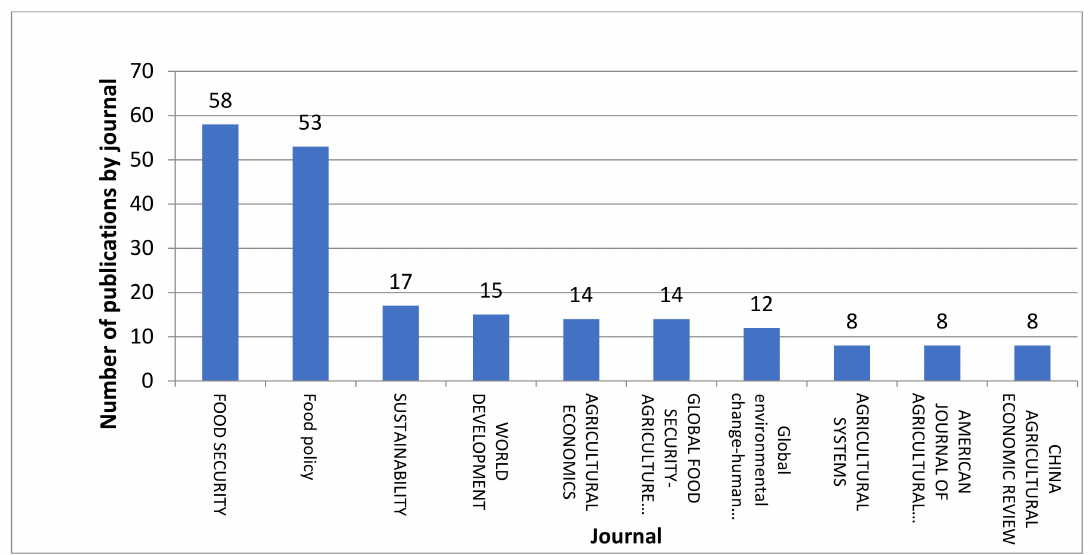
Figure 3. Classification of journals according to the publication number. Source R studio results.